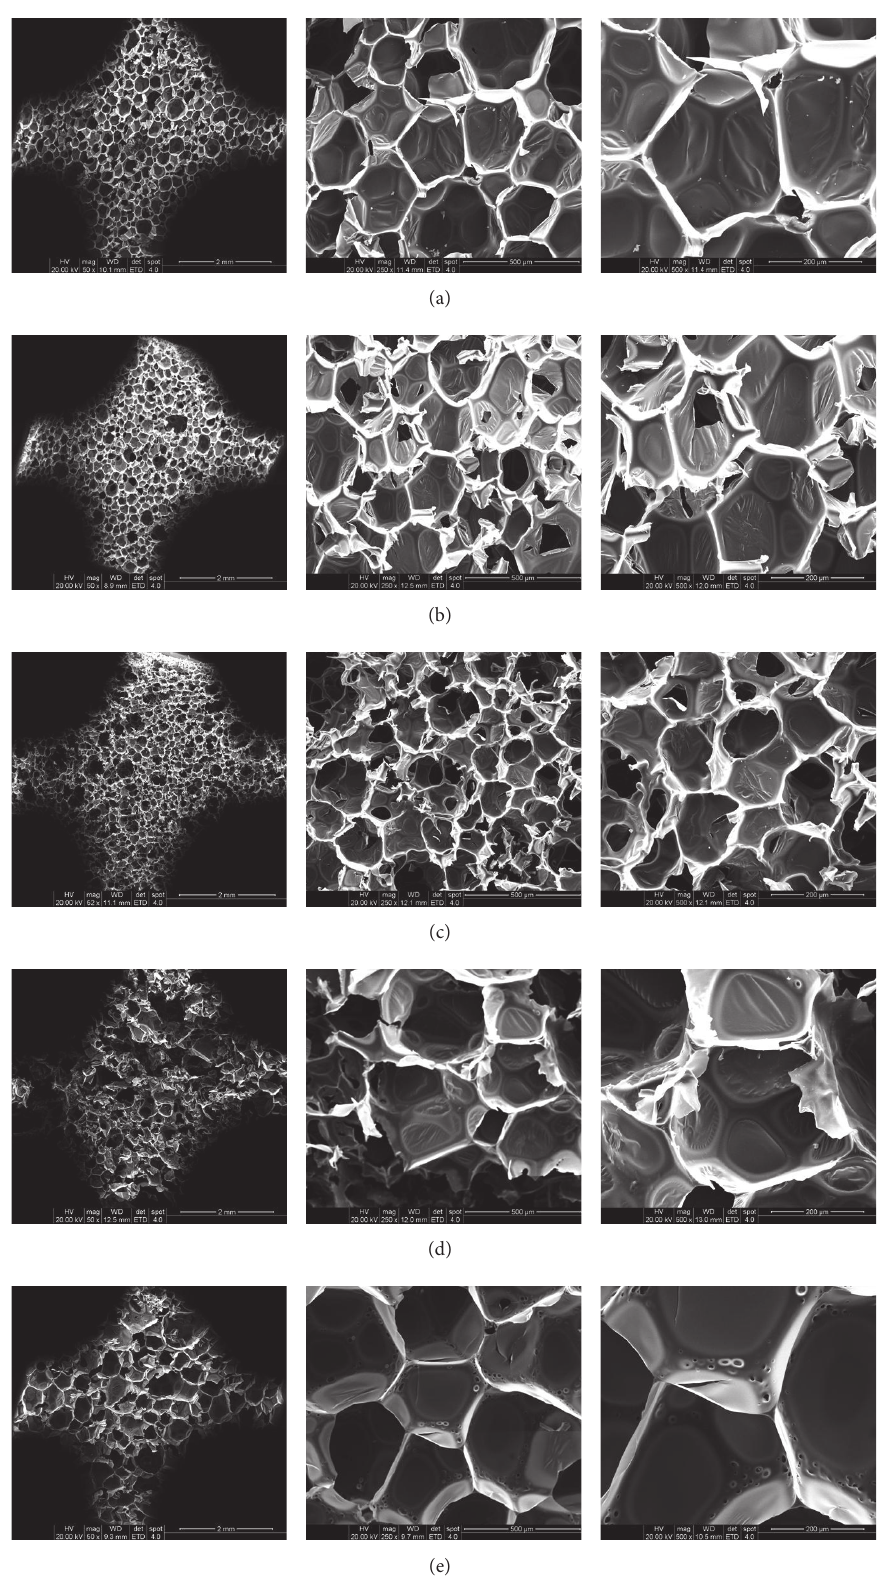
Figure 4: SEM photos of CG samples ((a) 10%, (b) 30%, (c) 50%, (d) 80%, and (e)